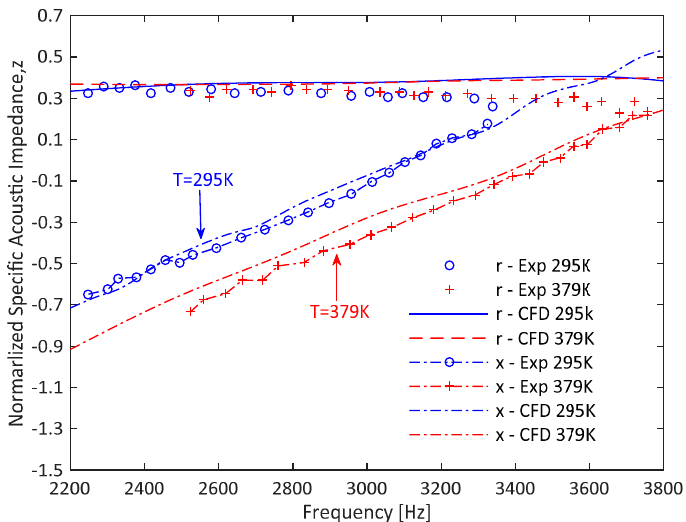
Figure 18. CFD and experimental comparison of normalized specific acoustic impedance ( M (cid:2917) = 0.25 )